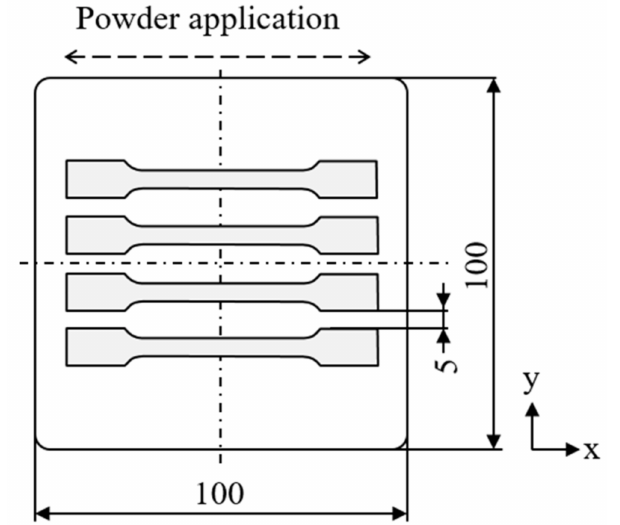
Figure 2. Schematic depiction of the build process layout relative to the powder coating orientation, units in mm.